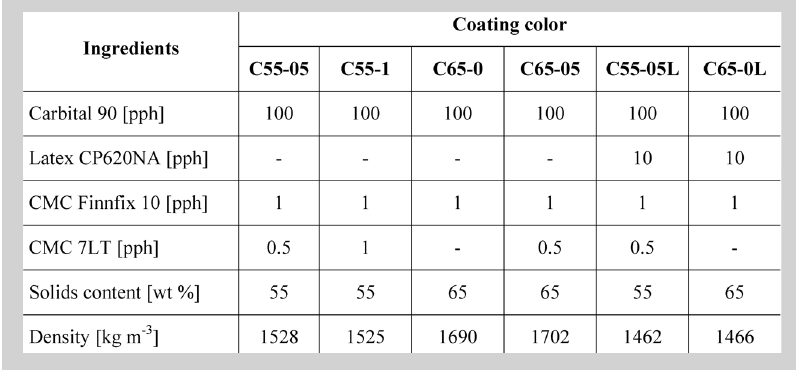
Table 1: Dried composition of coating colors (pph of pigment